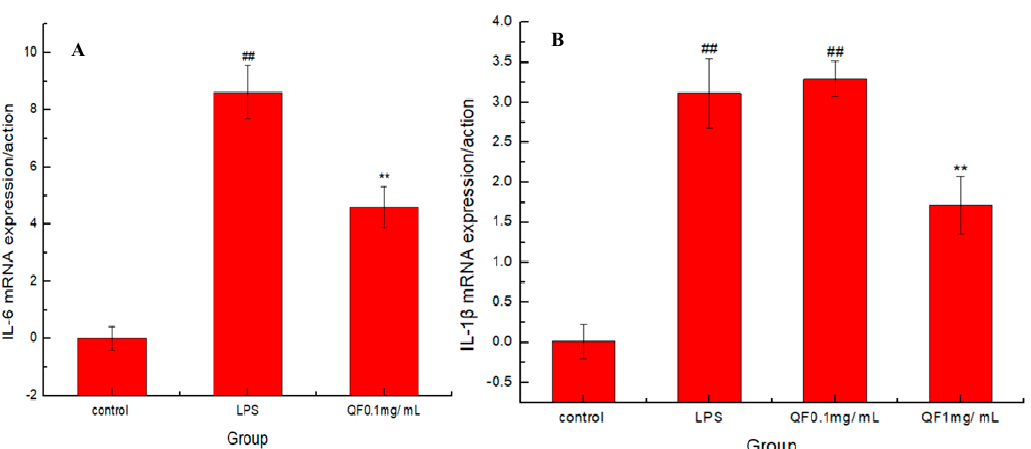
Figure 1. Effects of Fangfeng extract on the production of pro-inflammatory cytokines (IL-6 and IL-1 β ) in LPS-induced BV-2 cells. ( A ) Effect on the production of proinflammatory cytokines IL-6, ( B ) Effect on the production of proinflammatory cytokines IL-1 β . All the experiments were repeated at least three times and similar results were observed. Values are mean ± SE, ( n = 4 samples/group). ## p < 0.01 vs. control group, ** p < 0.01 vs. LPS-treated group.